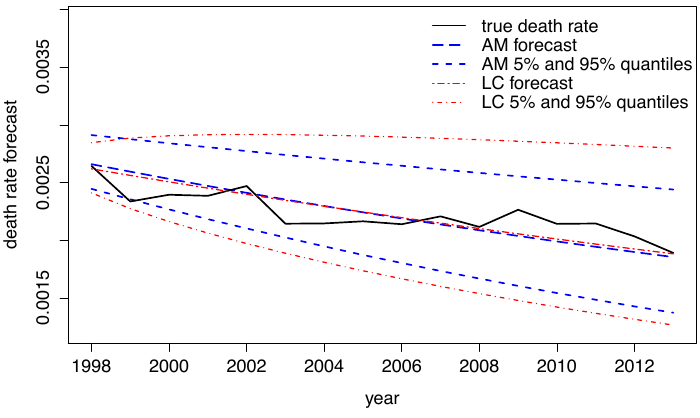
Figure 5. Forecasted and true death rates using the ECRP model (AM) and the Lee–Carter model (LC) for females aged 50 to 54